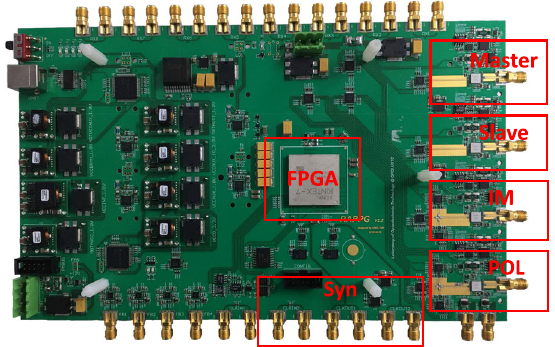
FIG. 12. Image of the electronics